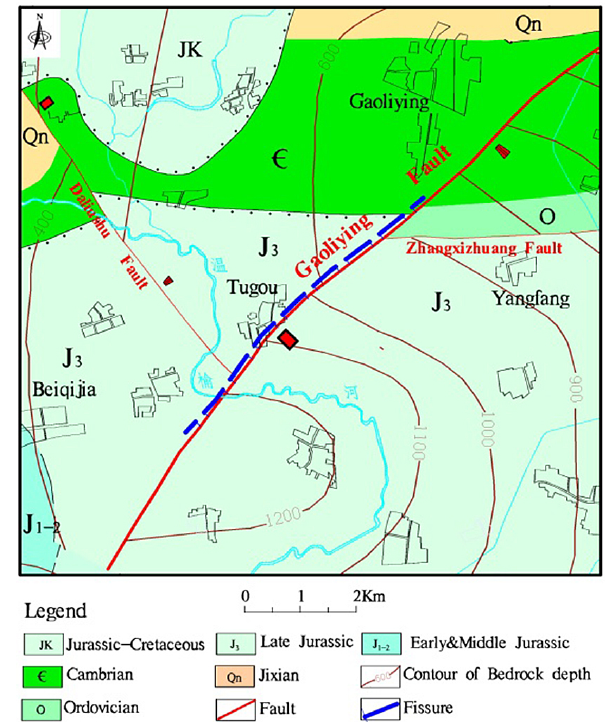
Figure 1. The plan distribution map of Gaoliying fissure and fault.